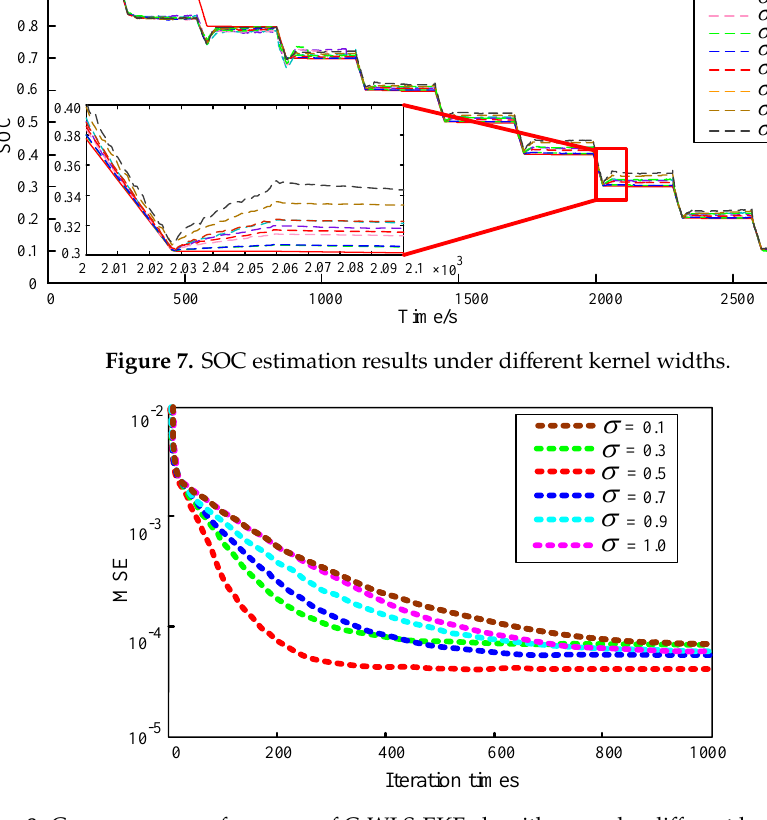
Figure 8. Convergence performance of C-WLS-EKF algorithms under different kernel widths.